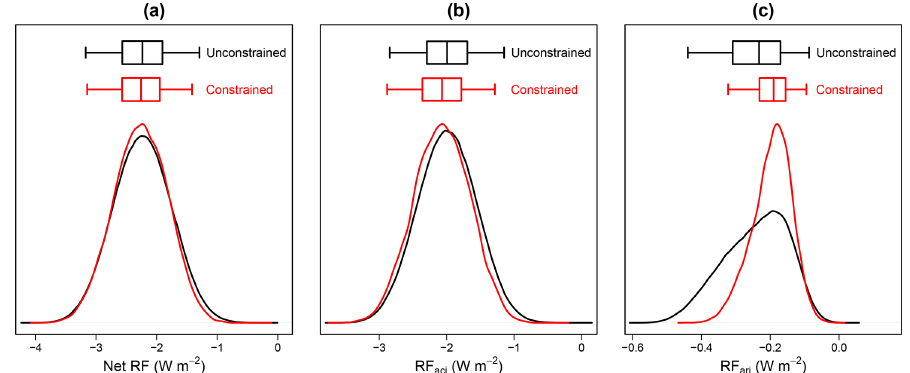
Figure 10. Effect of observational constraint using all measurement types on the probability distribution of global annual mean aerosol radiative forcing: (a) net RF, (b) RF aci (aerosol–cloud interaction) and (c) RF ari (aerosol–radiation interaction). The black line shows the prior (unconstrained) distribution and the red line shows the constrained distribution. For each box-and-whisker plot, the box represents the interquartile range split at the median forcing (the line inside the box), and the whiskers extend to the lower and upper bounds of the 95% credible interval of the